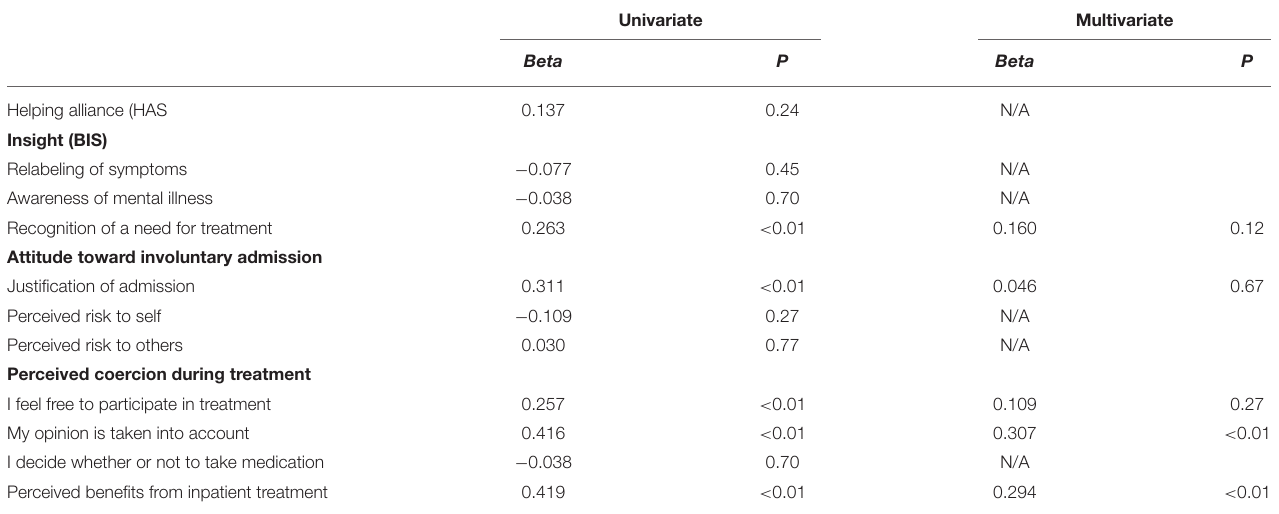
TABLE 4 | Determinants of subjective quality of